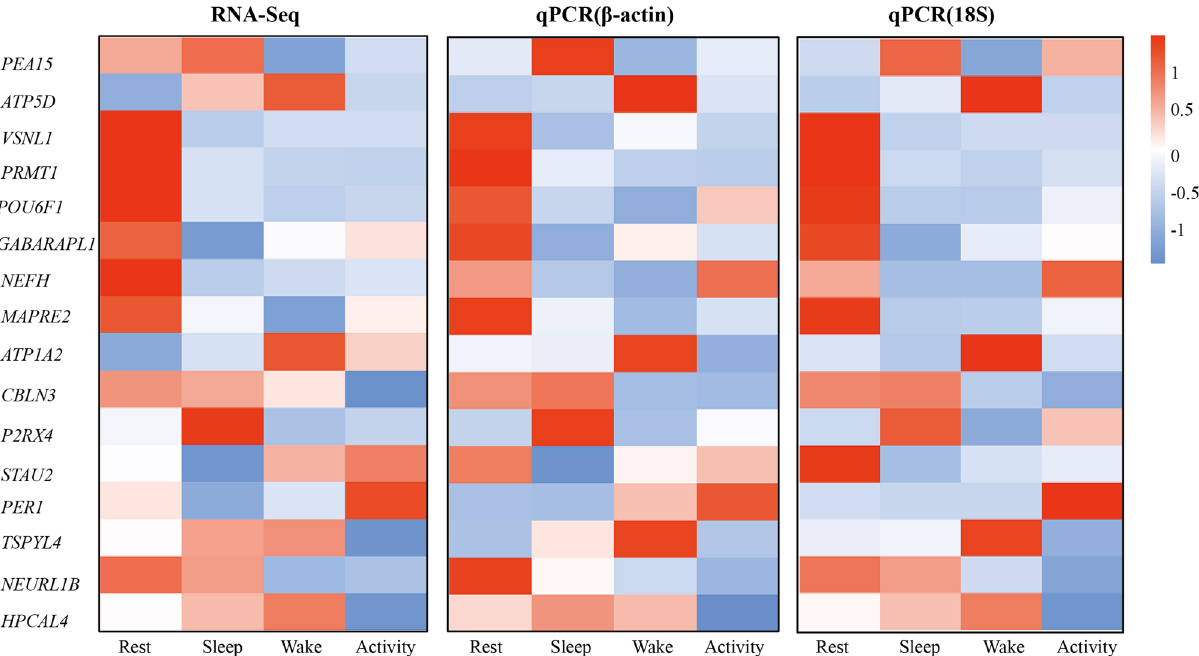
Figure 5. Comparisons of 16 differentially expressed genes by qPCR for technical validation. Heatmap from left to right representing log 2 fold change expression values from RNA-Seq (TPM) and qPCR (using β-actin and 18S for normalisation). The correlation coefficient between log 2 fold change expression values detected by RNA-Seq and qPCR was 0.455 ( p < 0.01).